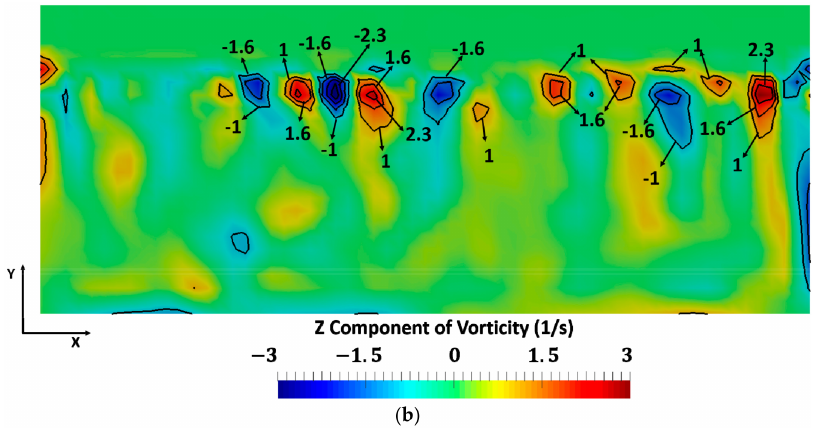
Figure 11. The component of the vorticity in the z direction on two xy planes for the case with a mass flow rate of 7.9 × 10 − 4 kg/s. ( a ) xy plane at the centre of the tank, i.e., Z = 0.455 m; ( b ) xy plane at the back of the tank, i.e., Z = 0.05.